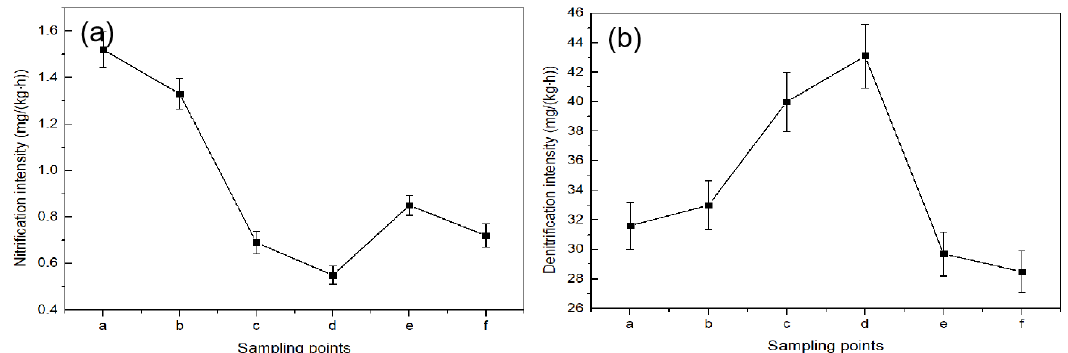
Figure 7. Nitrification and denitrification intensity along the O-A-O-CW (aerobic / anaerobic / aerobic three-stage aquatic vegetable wetland). ( a ) Nitrification intensity along the wetland, ( b ) Denitrification intensity along the wetland.